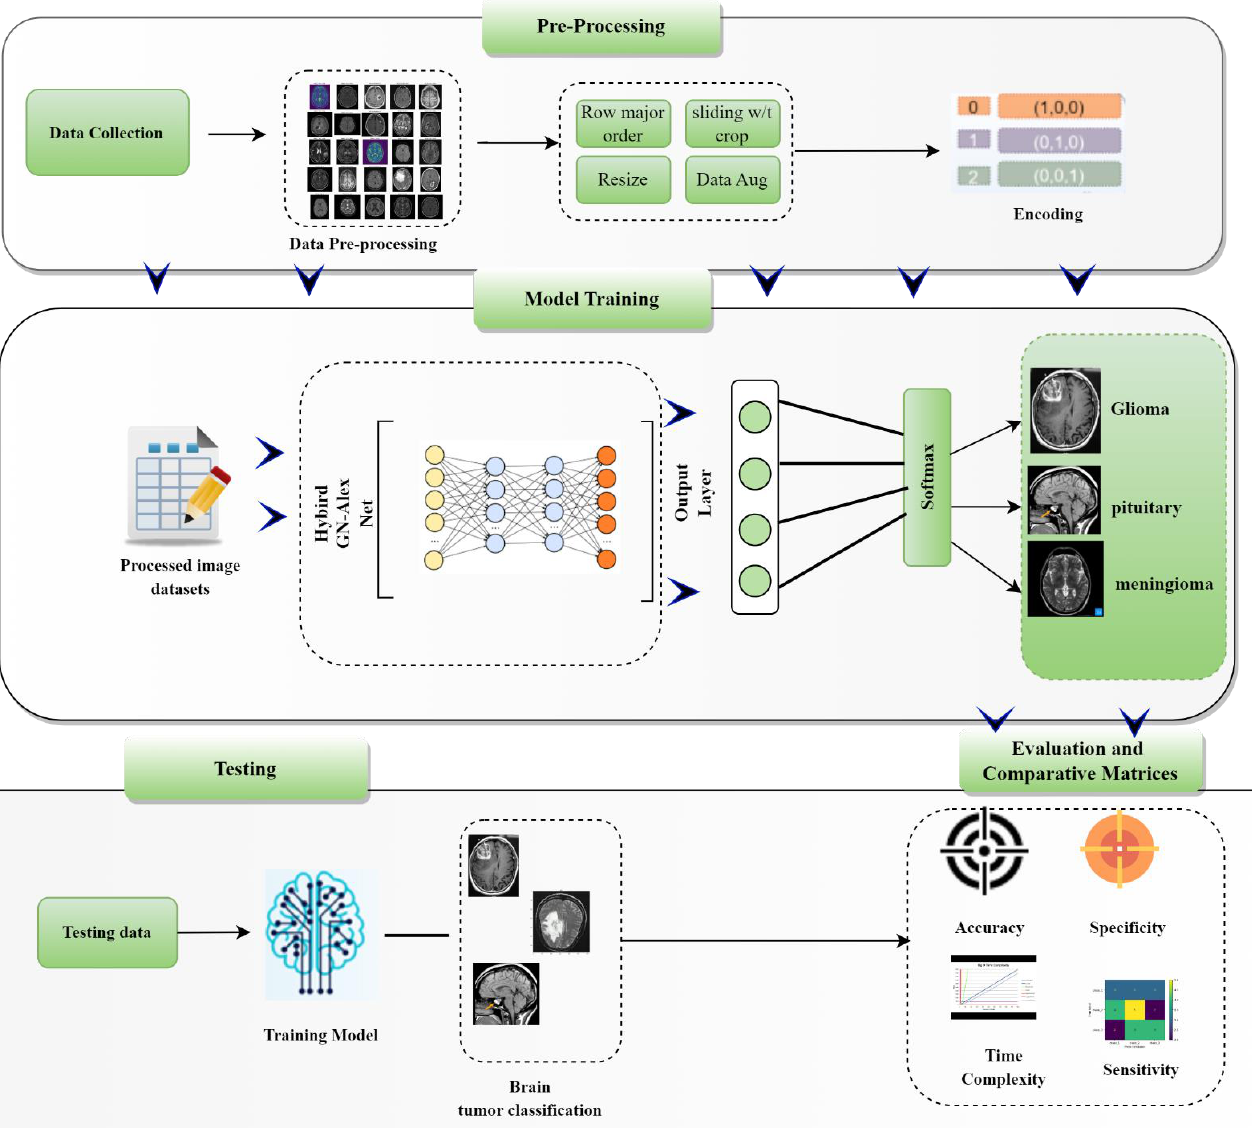
Figure 1. The block diagram of the framework for BT classification using the proposed GN-AlexNet deep learning model.